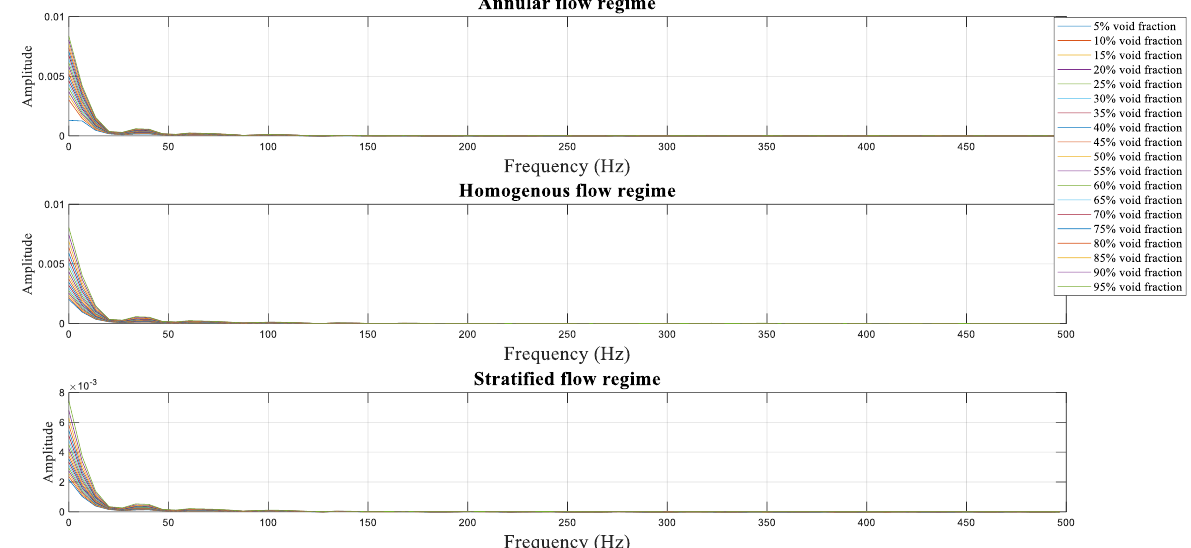
Figure 6. The transferred signals to the frequency domain correspond to three regimes of annular,